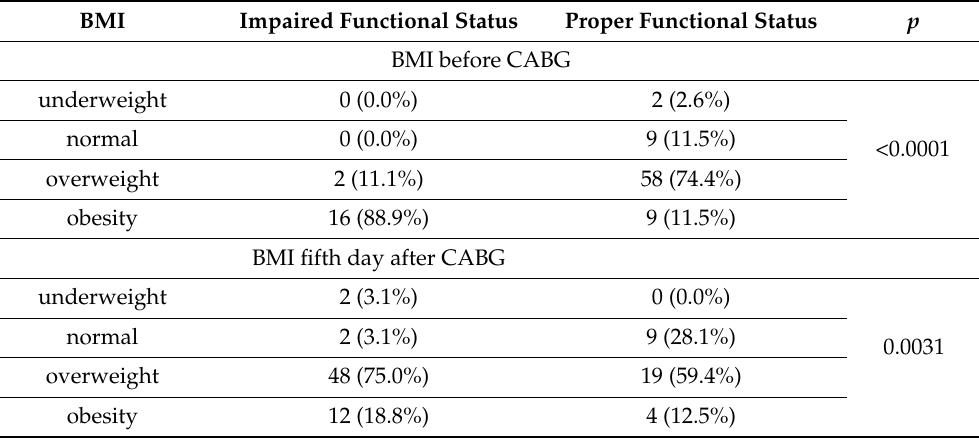
Table 9. Relationship between BMI and the level of the patients’ independent functioning (ADL). BMI Impaired Functional Status Proper Functional Status p BMI before CABG underweight 0 (0.0%) 2 (2.6%) <0.0001normal 0 (0.0%) 9 (11.5%) overweight 2 (11.1%) 58 (74.4%) obesity 16 (88.9%) 9 (11.5%) BMI fifth day after CABG underweight 2 (3.1%) 0